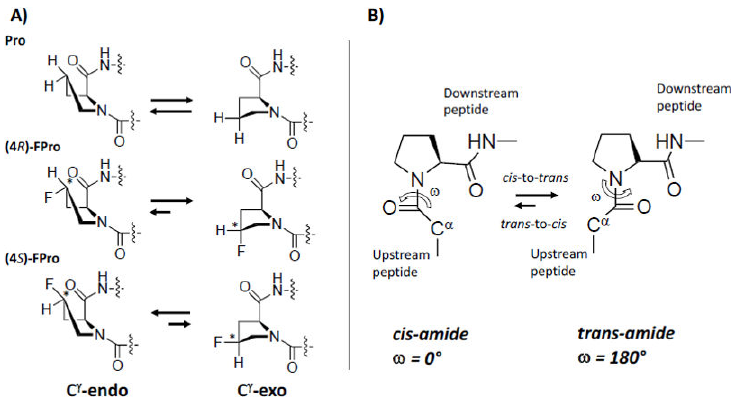
Figure 2. Fluorine effect on proline conformation. ( A ) pyrrolidine ring puckers in proline, (4R)-FPro, and (4S)-FPro. Fluorine on the C γ atom introduces a chiral center (indicated by *) with effect on the preference of endo/exo-pucker. ( B ) cis/trans isomerization by Pro. Figure adapted from Ref.